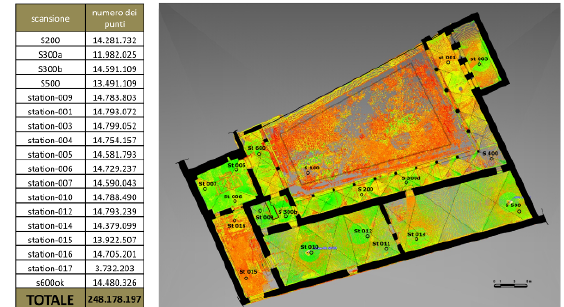
Figure 4. Positions of the stations and the number of points captured for the Beata Antonia’s monastery.